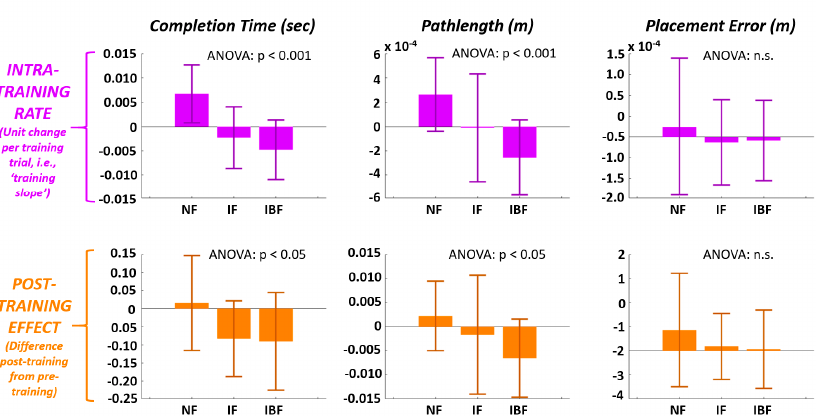
Figure 6. Intra-training rate and post-training change shown for each performance metric and compared across training feedback groups (NF = No Feedback, IF = Immediate Feedback, IBF = Intentional Binding Feedback). Intra-training rate indicates the average change in performance metric per training trial. Post-training change is difference in performance metric during post-training trial-block compared to pre-training trial-block. Table 4. ANOVA for intra- and post-training performance outcomes between training conditions (feedback modes). Feed- back Modes: NF = No Feedback, IF = Immediate Feedback, IBF = Intentional Binding Feedback.